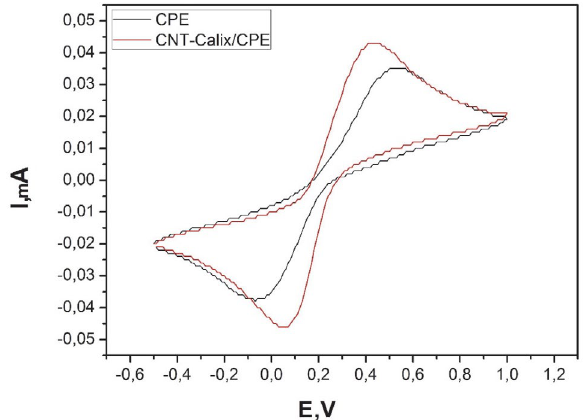
Fig. 4. Cyclic voltammograms of CPE and CNT-Calix at 100 mV s ‒1 , in 0.20 mol L −1 PBS solution containing 0.05 M K 3 Fe(CN) 6 / K 4 Fe(CN) 6 (1:1, pH = 5.0)